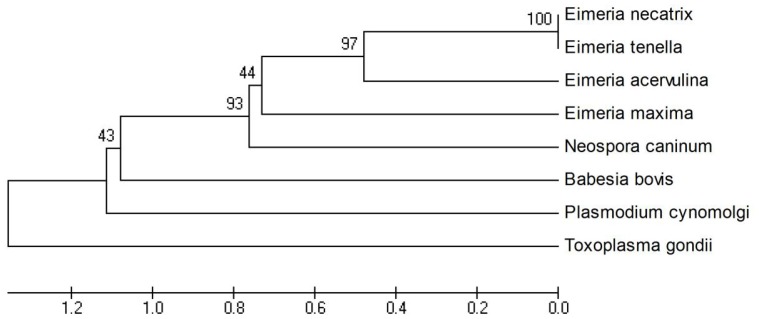
The phylogenetic tree of amino acid sequences between EaMIC5 and those of MIC5 from other species.